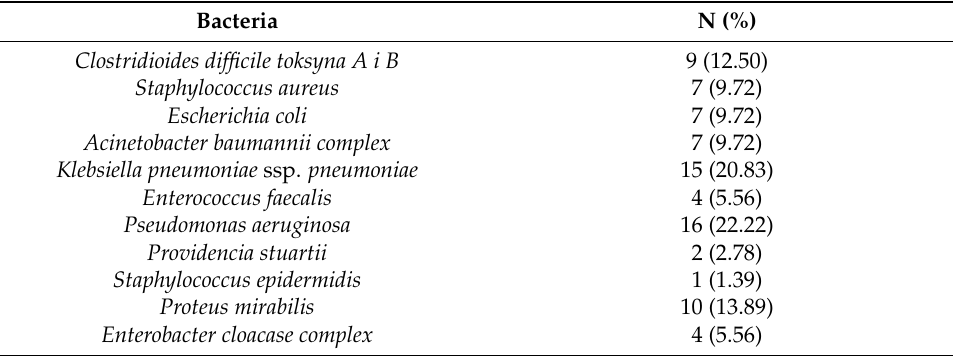
Table 3. The frequency of different bacteria causing nosocomial infections occurs.